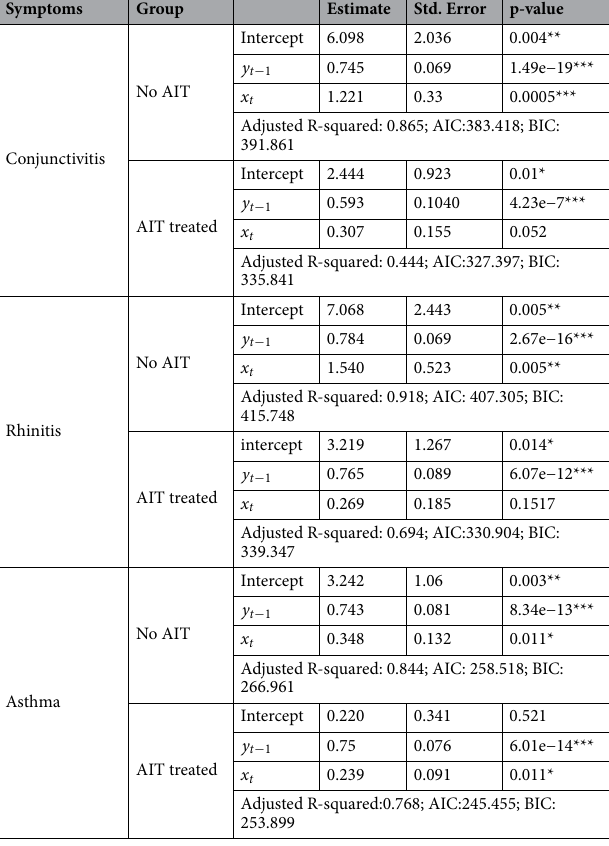
Table 7. Estimation of the Autoregressive Distributed Lag (ARDL) model (1) in the two groups of patients for conjunctivitis, rhinitis, and asthma-like symptoms. Signif. codes: 0 ‘***’ 0.001 ‘**’ 0.01 ‘*’ 0.05 ‘.’ And 0.1 ‘ ’